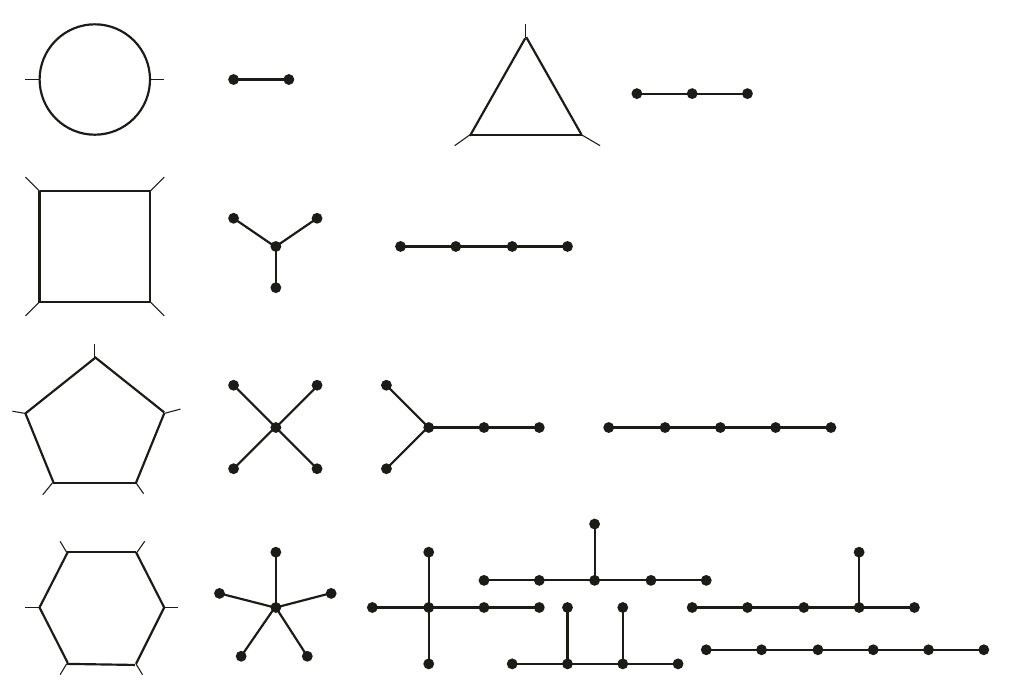
Figure 6 . One-loop diagrams and their snowflake